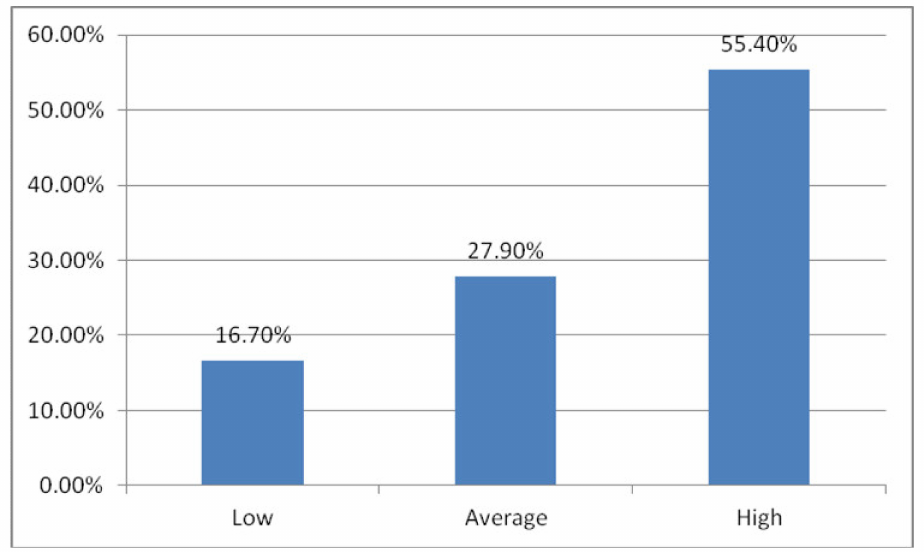
Figure 1. Distribution of PSS-10 results (sten scale indicating level of perceived stress) in the study